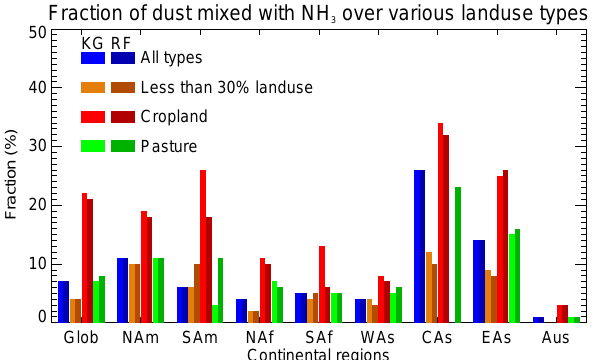
Fig. 3. Annual mean fraction (%) of M-DB2 dust column burden mixed with IASI NH 3 over all land surfaces (blue), areas with less than 30% land-use (brown), cropland (red), and pasture (green) globally and over 8 continental regions, considering the Klein Gold- ewijk (2001) (KG) and Ramankutty and Foley (1999) (RF) land-use datasets, with the latter shown using darker